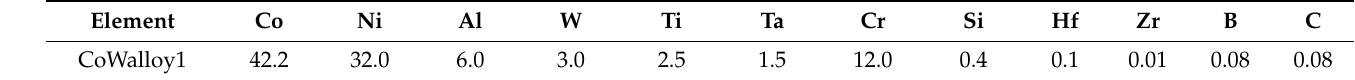
Table 1. Nominal alloy composition of CoWAlloy1 in